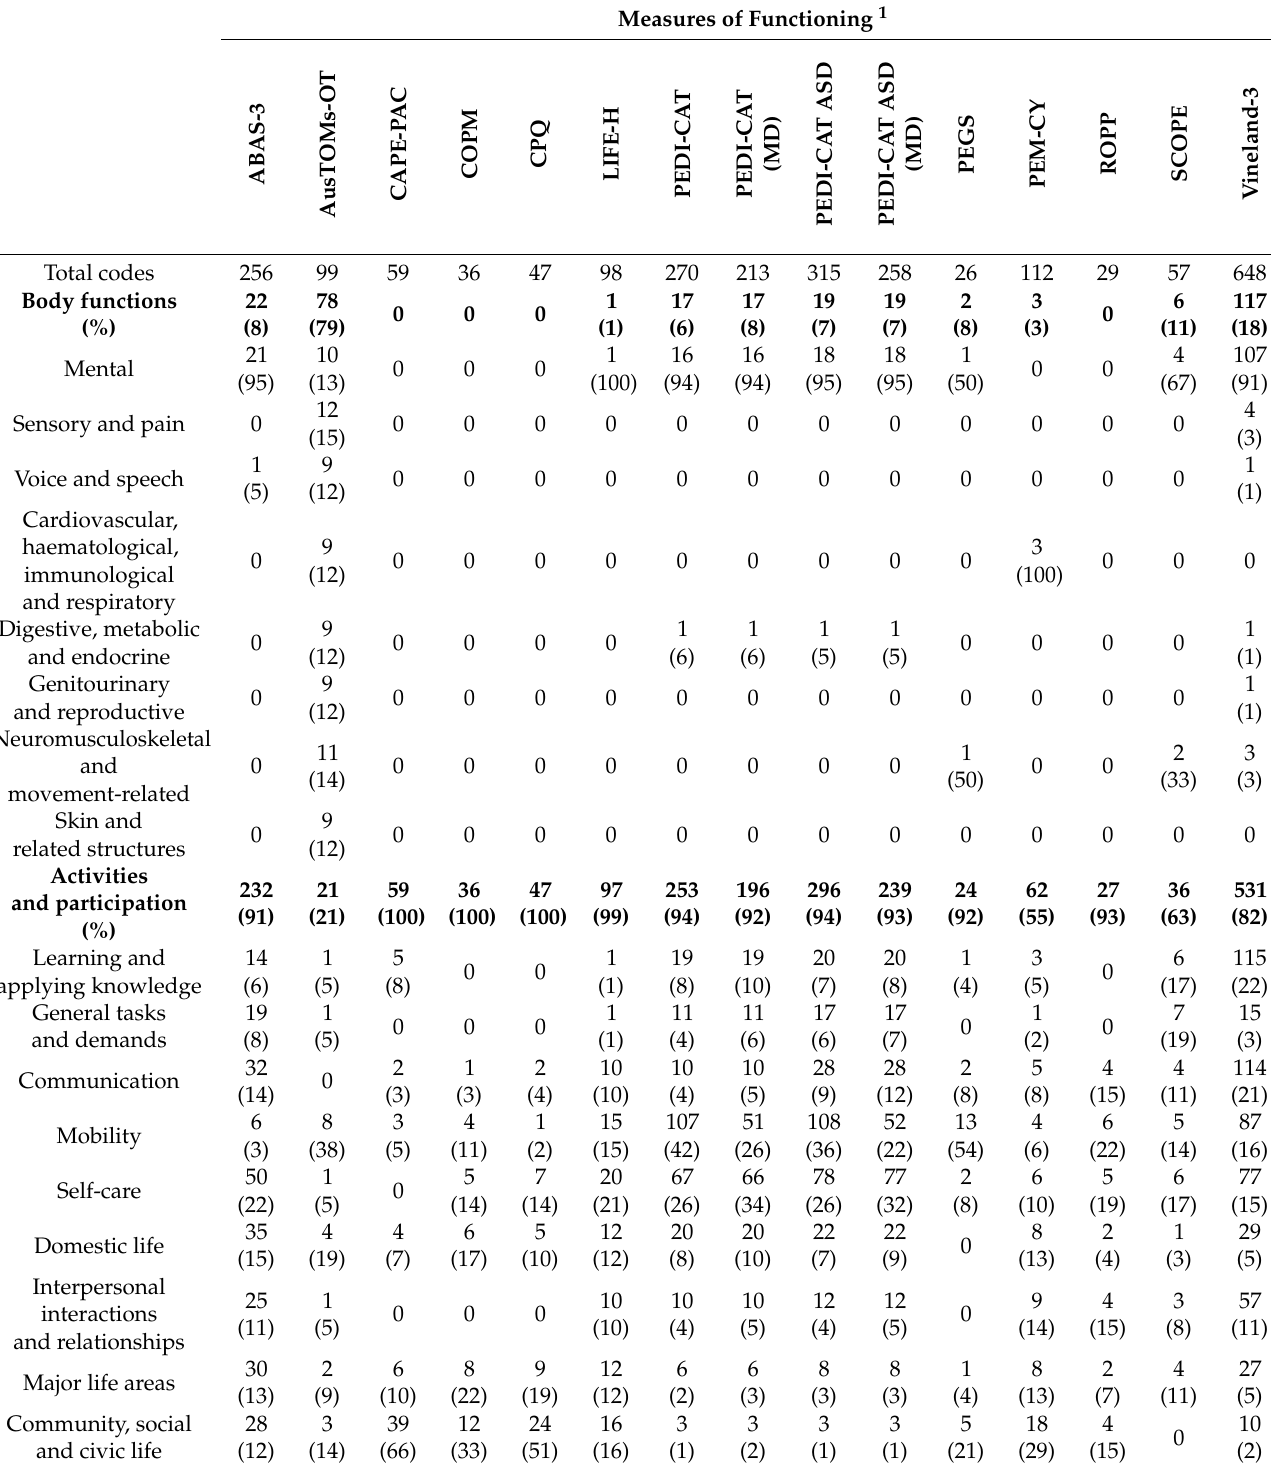
Table 5. Distribution of codes linked to the International Classification of Functioning, Disability and Health [17] components and